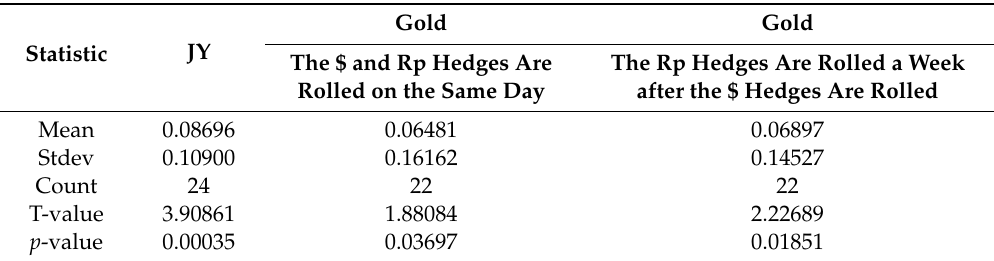
Table 6. US $ (low c) h T − Rp (high c) h T .